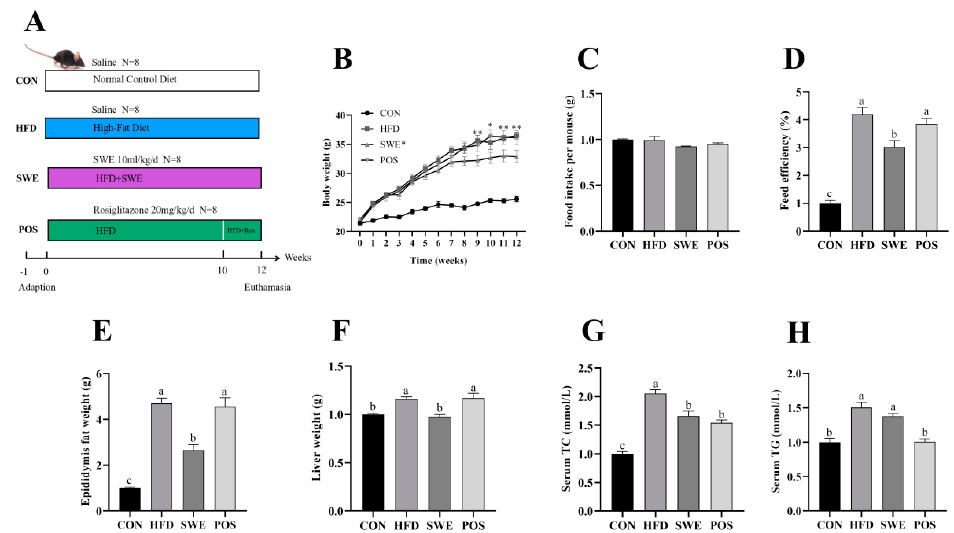
Figure 1. Effects of SWE on growth performance in the HFD − fed mice. ( A ) schema showing the animal groups and treatments, ( B ) body weight change, ( C ) food intake, ( D ) feed efficiency (body weight gain/food intake), ( E ) epididymis fat weight, ( F ) liver weight, ( G ) serum TC level, ( H ) serum TG level. Values are expressed as mean ± S.E.M. (* p < 0.05, ** p < 0.001, vs. SWE). Means marked with superscript letters are significantly different to the others ( p < 0.05). n = 6 − 8 per group.